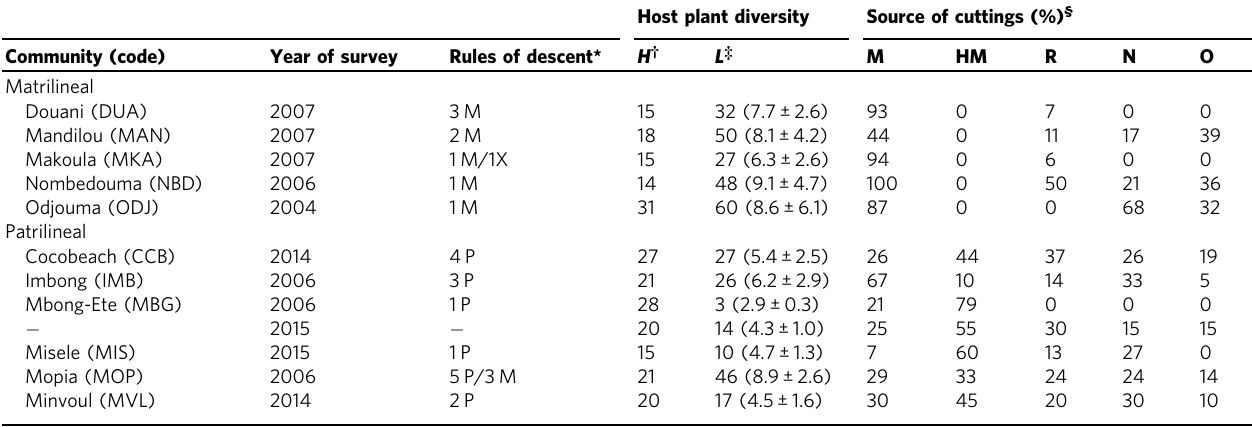
*Number of groups with patrilineal (P), matrilineal (M) or mixed (X) descent. All populations in Gabon are structured in virilocal exogamous lineages (details in Supplementary Data 1). † Number of households surveyed. ‡ Number of landraces recorded in the village (corrected for the presence of synonymies and omitting unnamed landraces), and average number of landraces per farmer ± SD (in brackets). § Percentageof farmersmentioningeach source(several sourcespossible): M motherormaternalgrandmother, HM husband ’ smother orgrandmother, R otherrelatives (sister,sister-in-law, aunt,niece, daugher-in-law, concubine in polygynous households), N neighbors, O other